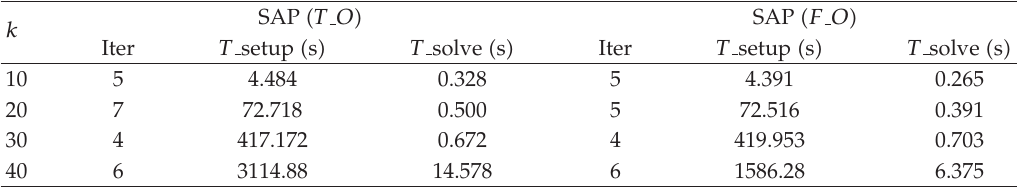
Table 3: Computational performance of Bi-CGSTAB with